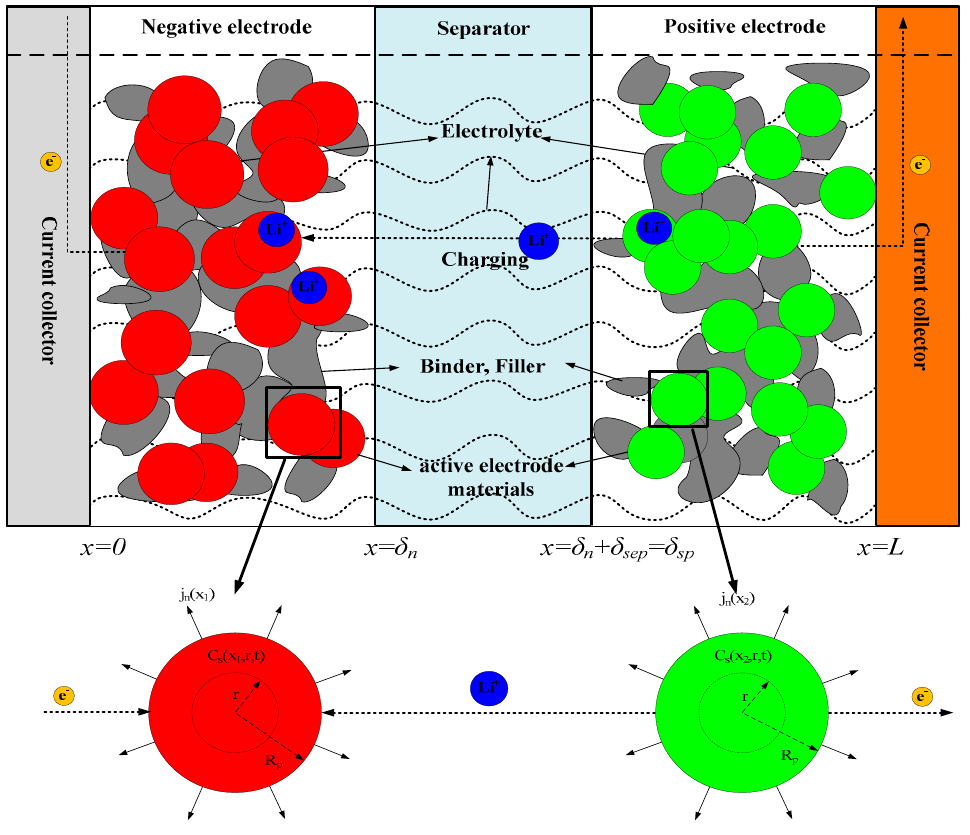
Figure 1. Schematic macroscopic ( x -direction) cell model with coupled microscopic ( r -direction) solid diffusion model.